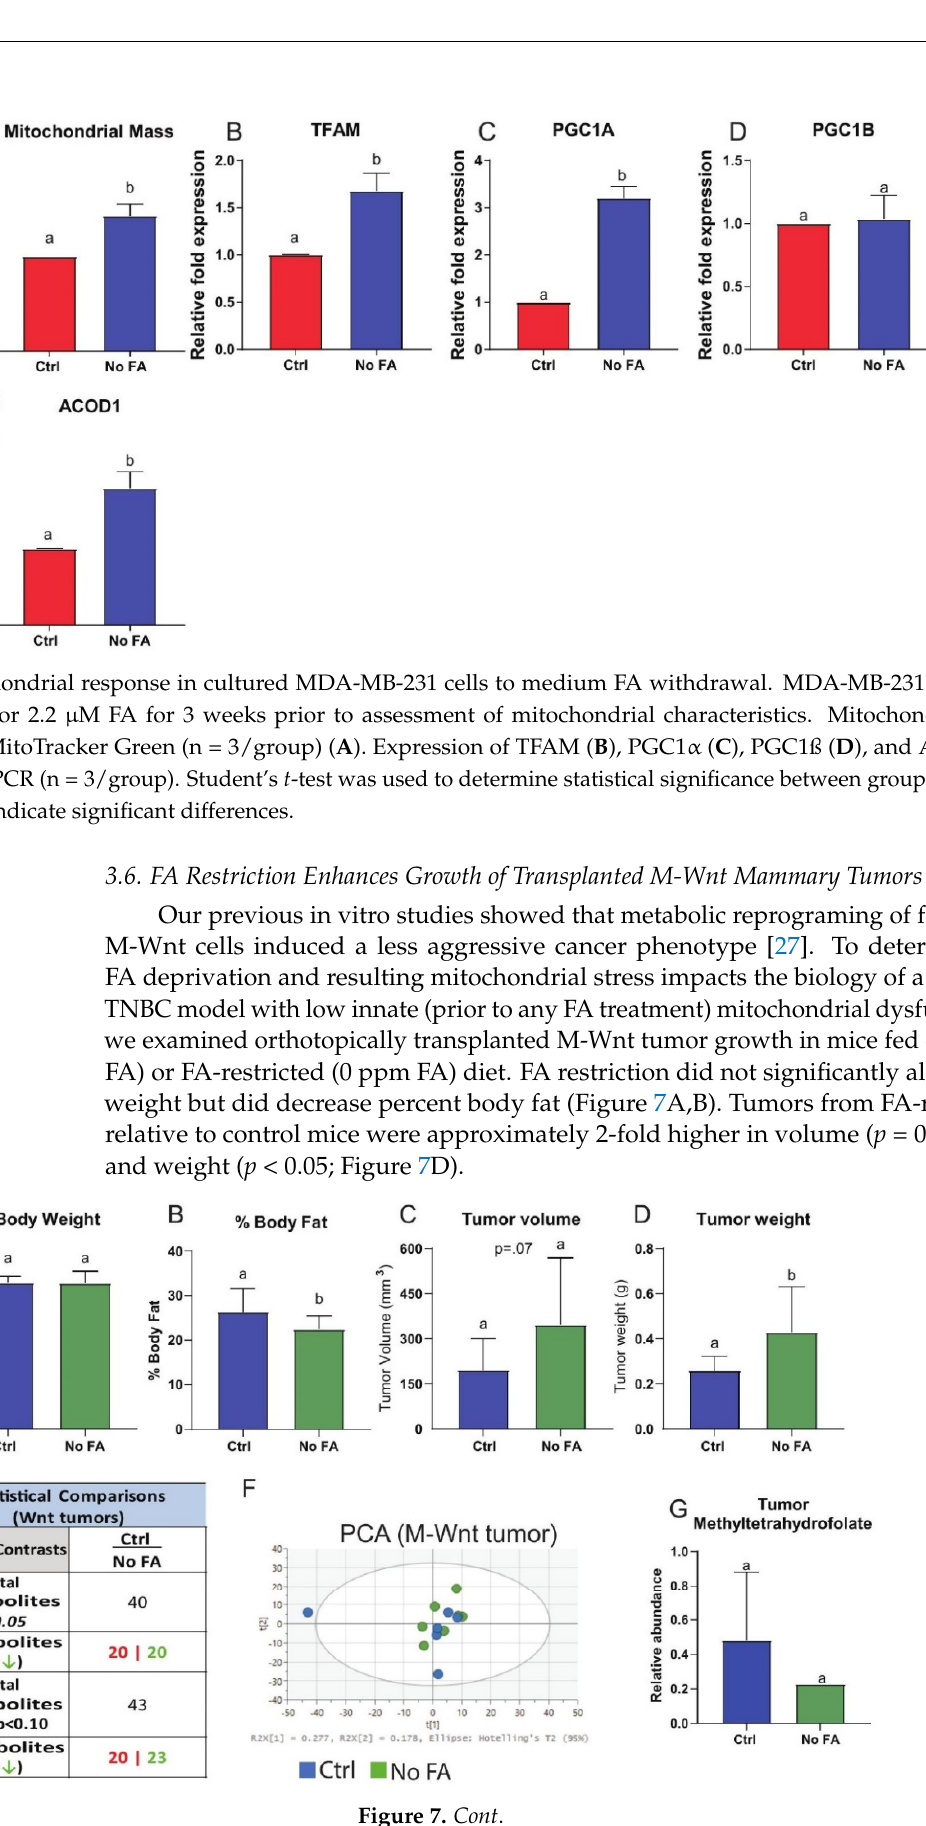
Figure 7. Dietary FA restriction enhances growth of orthotopically transplanted M-Wnt mammary tumors and minimally effects tumor metabolomic profile. Body weight of mice fed different folate diets for 3 weeks ( A ) (n = 10–14/group). Body composition determined by echo MRI ( B ) (n = 10–14/group). Ex vivo tumor volume ( C ) and weight ( D ) (n = 9–13/group). Summary of tumor metabolomics ( E ), PCA of tumor metabolomics ( F ) (n = 6/group). Tumor metabolite levels of 5-mTHF ( G ) (n = 6–7/group), different letters indicate significant differences. 3.7. FA Restriction Minimally Alters M-Wnt Tumor Metabolomic Profiles, Glycolysis, and PPP Metabolism Untargeted metabolomics analysis on M-Wnt tumors from mice fed 0 ppm versus 2 ppm FA diets showed that of the 760 named metabolites, 40 displayed diet-dependent differences (Figure 7E,F, Table S4). This was approximately half of the metabolite differ- ences observed in MDA-MB-231 (FA-restricted relative to control; Figure 1F). FA re- striction, relative to control, did not alter M-Wnt tumor 5-mTHF levels (Figure 7G), gly- colysis, PPP, or one-carbon metabolism, in terms of metabolite levels (Table S4).